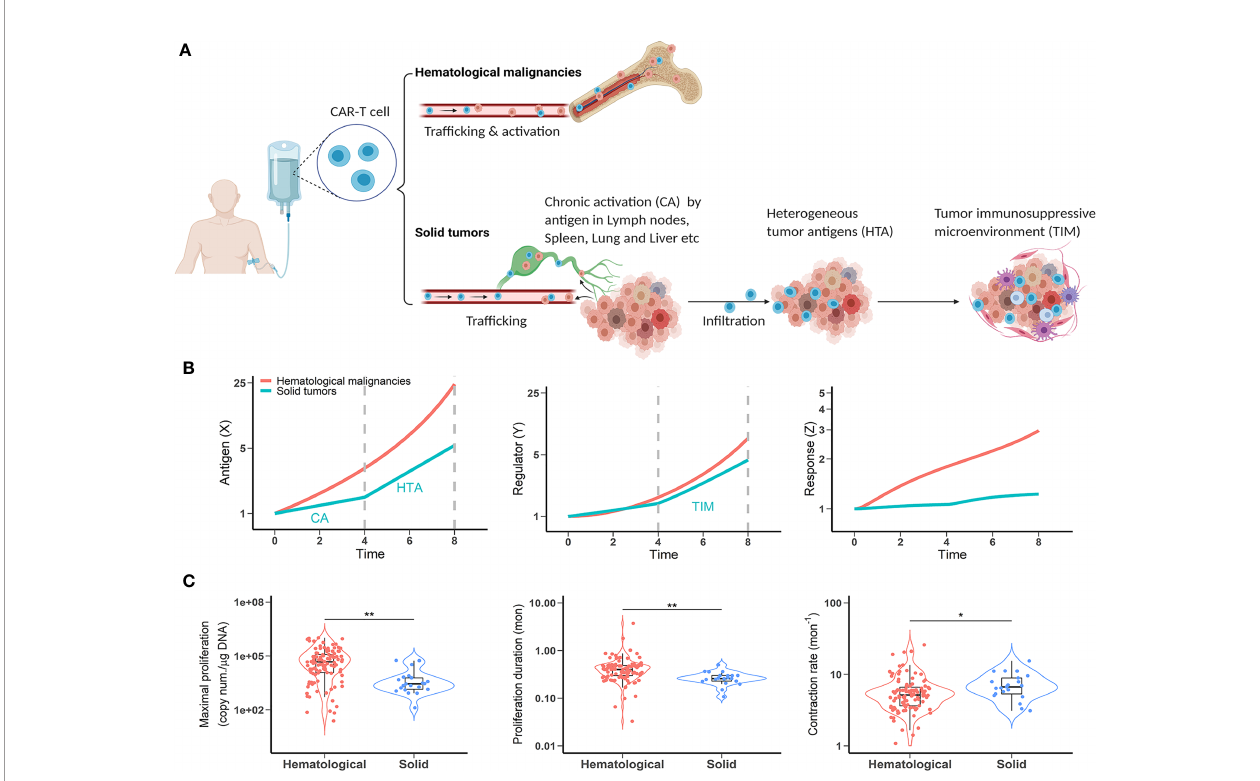
FIGURE 3 | CAR-T cells have restricted activation in solid tumors. (A) A comparison of antigen exposure between hematological and solid malignancies and clinical observations. (B) The dynamic pro fi les of antigen stimulus (left), regulators (middle) and CAR-T response (right) in hematological and solid malignancies. When simulating mild chronic X to re fl ect chronic activation (CA) before tumor followed by exposure to highly heterogeneous antigen-expressing cells in the tumor (HTA), response (Z) is dampened by the TIM (part of Y). Vertical dashed lines indicate CAR-T cell distribution phases before (time 0-4) and after (time 4-8) tumor in fi ltration. (C) Clinical observations of CAR-T cellular kinetics in hematological malignancies and solid tumors. Left, maximal proliferation (the peak concentration of CAR copies, p < 0.001); Middle, proliferation duration (time from infusion to the peak concentration, p < 0.001); Right, contraction rate (slope of decline following initial peak, p < 0.05). The data points are from multiple CAR-T trials and according to our model-based cellular kinetic analysis